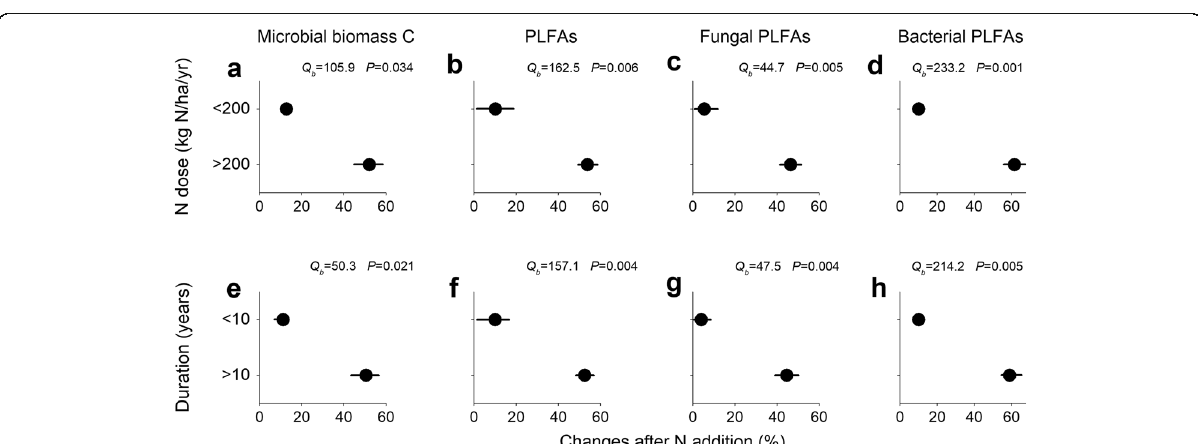
Fig. 5 Percent changes in microbial biomass under different magnitudes (upper) and durations (lower) of N addition. a , e Microbial biomass C based on chloroform fumigation extraction analysis, b , f total phospholipid fatty acids (PLFAs), c , g fungal PLFAs, and d , h bacterial PLFAs. Error bars represent the 95% bootstrap confidence intervals that were calculated by weighted effect sizes. The responses of these variables to different magnitudes and durations of N addition are considered significant ( P < 0.05) if the 95% bootstrap confidence intervals do not overlap with zero. The between-group heterogeneities ( Q b ) and the probabilities ( P ) of the effects of N addition on microbial biomass across different magnitudes and durations are shown in each